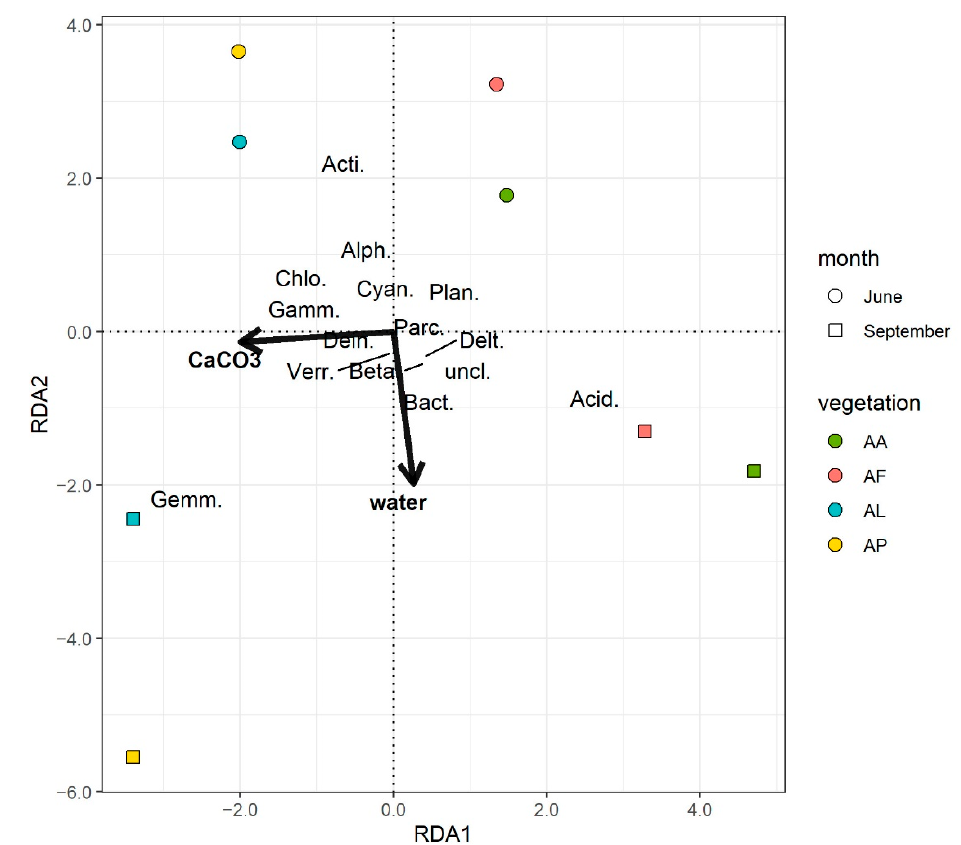
Figure 6. Redundancy analysis plot of the final model for the phylogenetic (NGS) data. All taxa were included in the analysis, but for better readability only those that had at least a 0.1 absolute value for both axes are depicted on the plot. The lengths of the arrows for the environmental variables were also doubled for visibility purposes. CaCO 3 : percentage of CaCO 3 , water: water content of the soil samples ( m/m %), Acid.: Acidobacteria, Acti.:Actinobacteria, Bact.: Bacteriodetes, Chlo.: Chloroflexi, Cyan.: Cyanobacteria, Dein.: Deinococcue-Thermus, Gemm.: Gemmatoidetes, Parc.: Parcubacteria, Plan.: Planctomycetes, Alph.: Alphaproteobacteria, Beta.: Betaproteobacteria, Delt.: Deltaproteobacteria, Gamm.: Gammaproteobacteria, Verr.: Verrucomicrobia, uncl.: Unclassified bacte- ria.